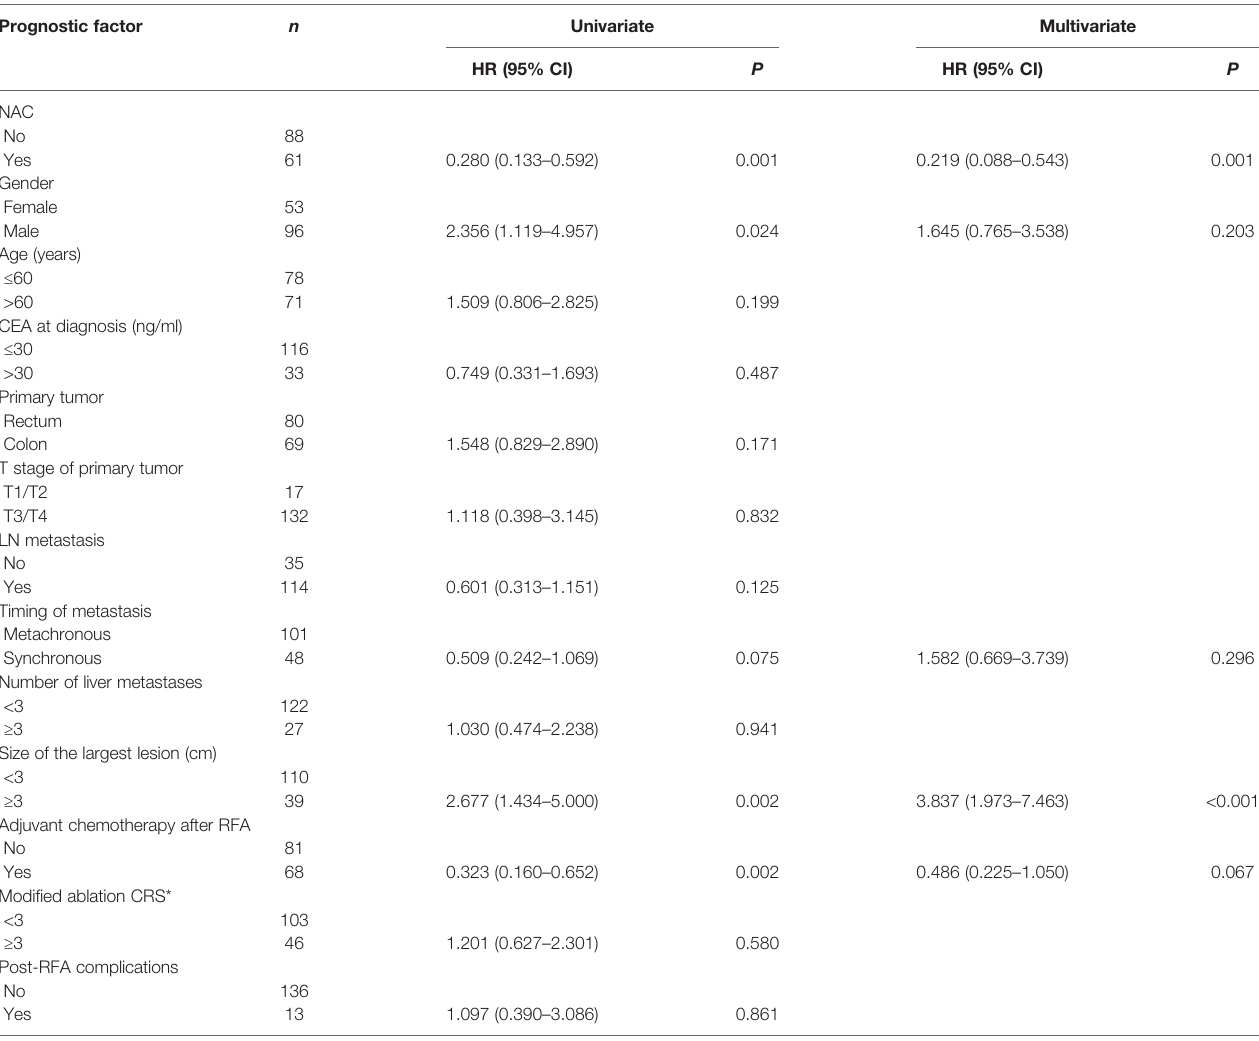
TABLE 4 | Analysis of prognostic factors associated with